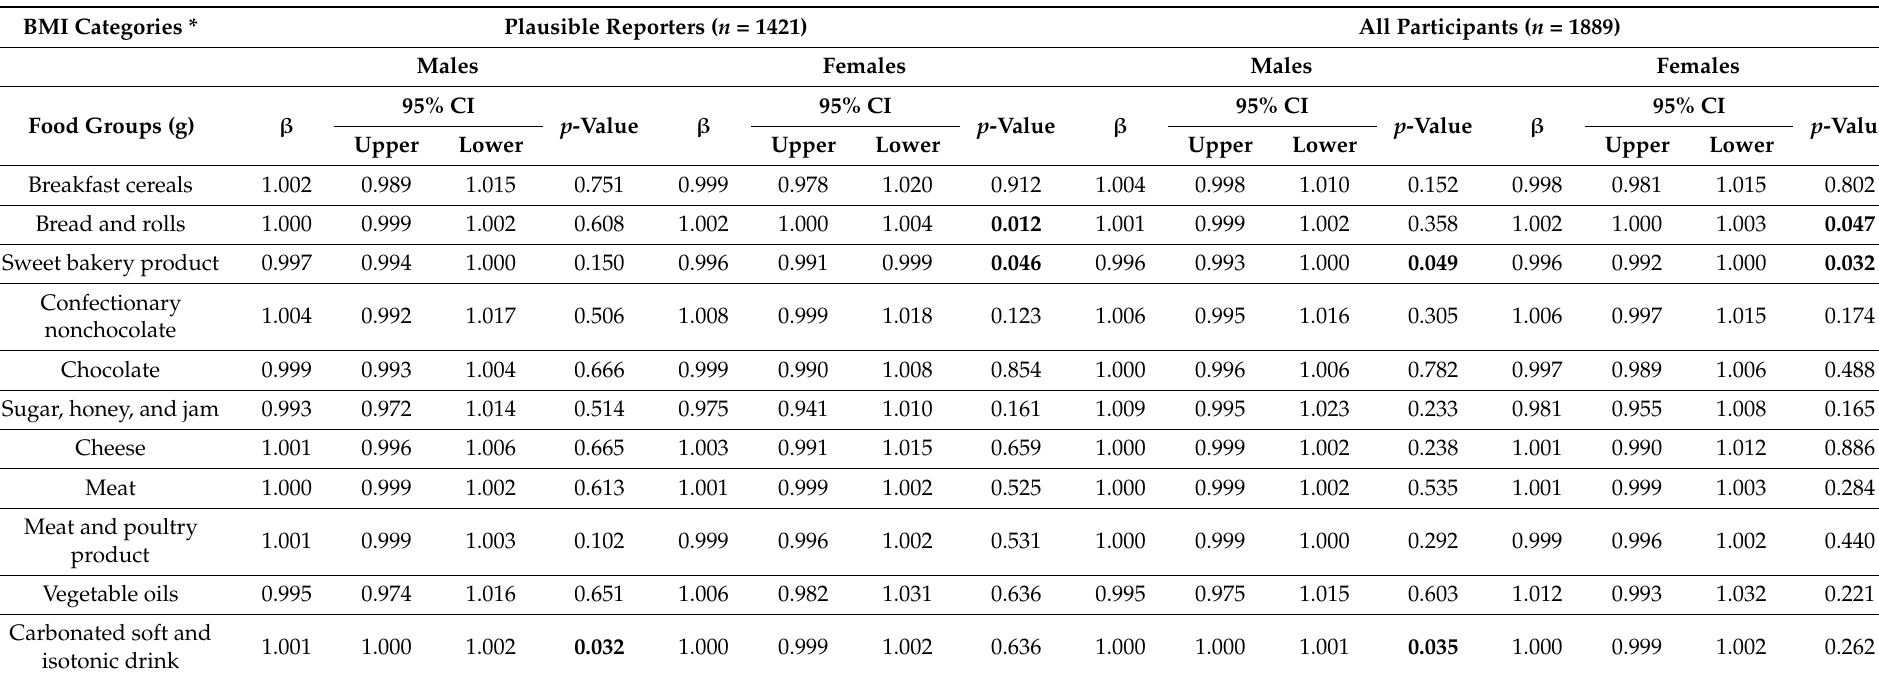
Table 5. Ordinal logistic regression model, the association between BMI categories and ED food portion groups between